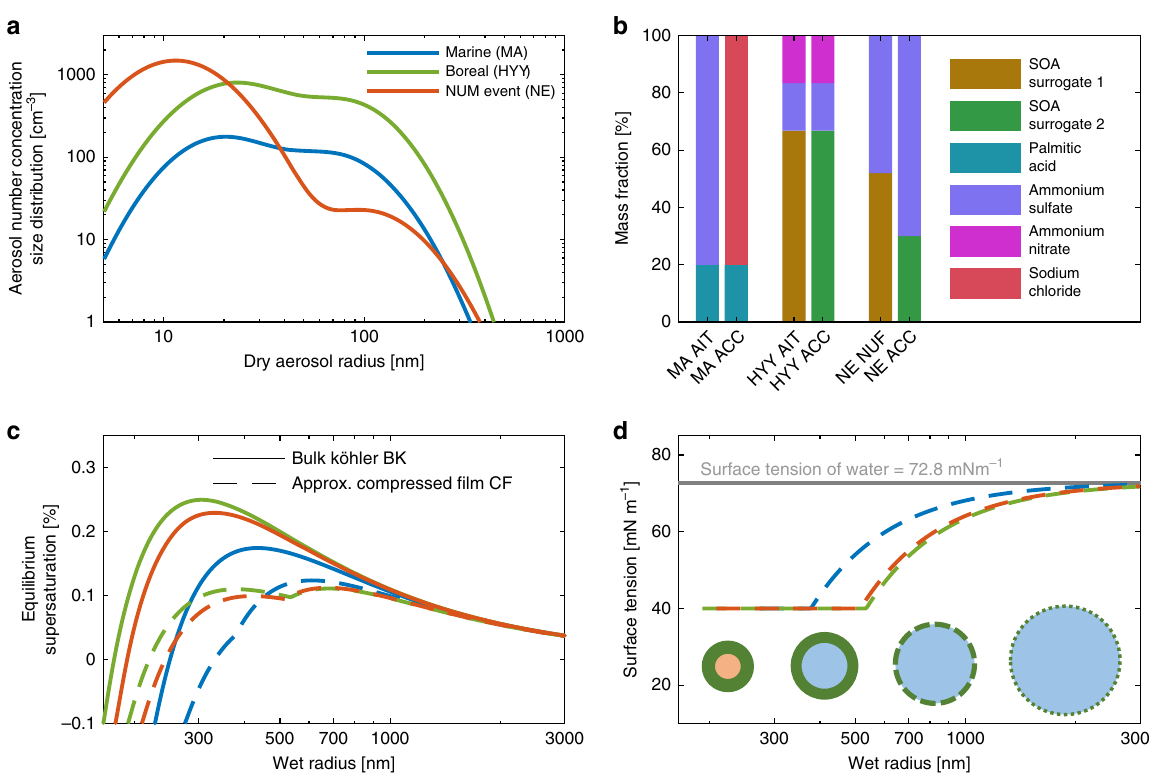
Fig. 1 Characterisation of marine (MA), boreal (HYY) and nascent ultra fi ne mode event (NE) aerosol populations and their thermodynamic description by Bulk Köhler (BK) and compressed fi lm (CF) models. a Dry aerosol number concentration size distributions for MA 52 (blue), HYY 31 (green) and NE 16 (orange) particle populations. b Assumed chemical composition of the particle populations. c Köhler curves corresponding to dry aerosol particles with 50 - nm radii and the compositions shown in b ). Solid and dashed curves correspond to bulk Köhler (BK) and compressed fi lm (CF) hydrometeor growth and phase structure descriptions, respectively. All Köhler curves are for Aitken mode compositions. d CF (dashed) and BK (solid, grey) surface tension curves corresponding to the 50 nm (in radius) Aitken mode particle Köhler curves displayed in b ). Below the curves, a schematic illustrates the thinning